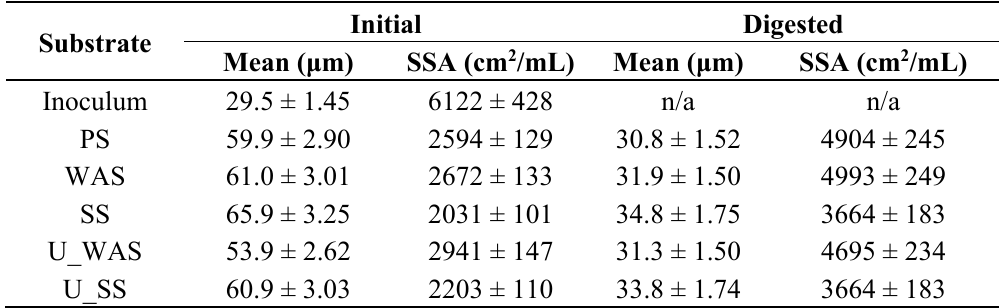
Table 2. Particle size analysis of substrate samples before and after ultrasound